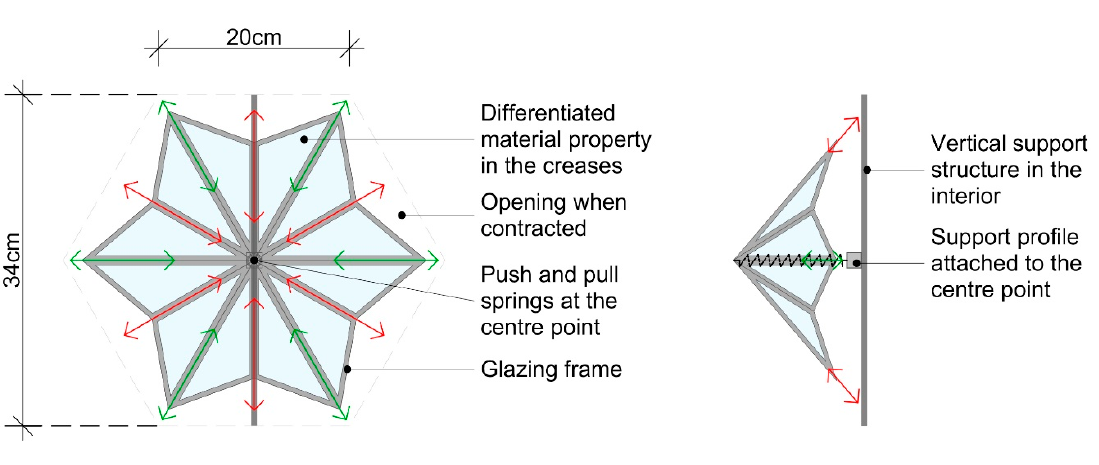
Figure 14. Movement and dimensions of the façade module in elevation and section, where red arrows represent the displacement of valley folds and green arrows represent the displacement of mountain folds.